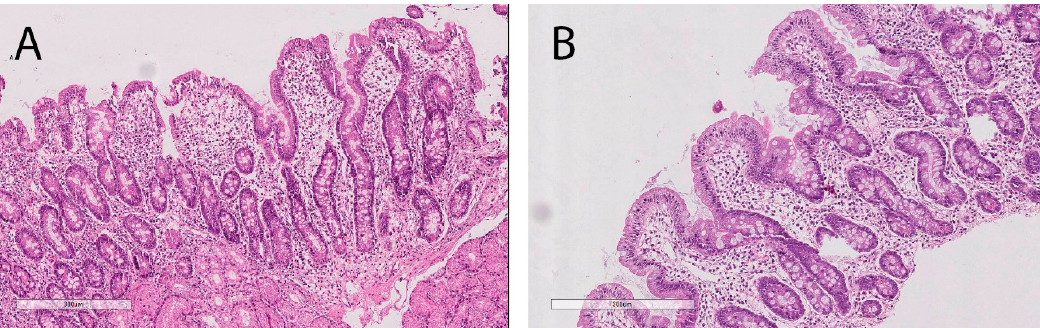
Figure 1. Histological examination of the duodenal biopsy. ( A ) Before gluten-free diet. Marsh stage 3b lesion of gluten-induced enteropathy characterized by broad, blunted villi, crypt elongation and increase in intra-epithelial lymphocytes (IELs). ( B ) Morphological improvement under gluten-free diet due to a return to normal villous architecture and a decrease in intra-epithelial lymphocytes (IELs). H&E. ×